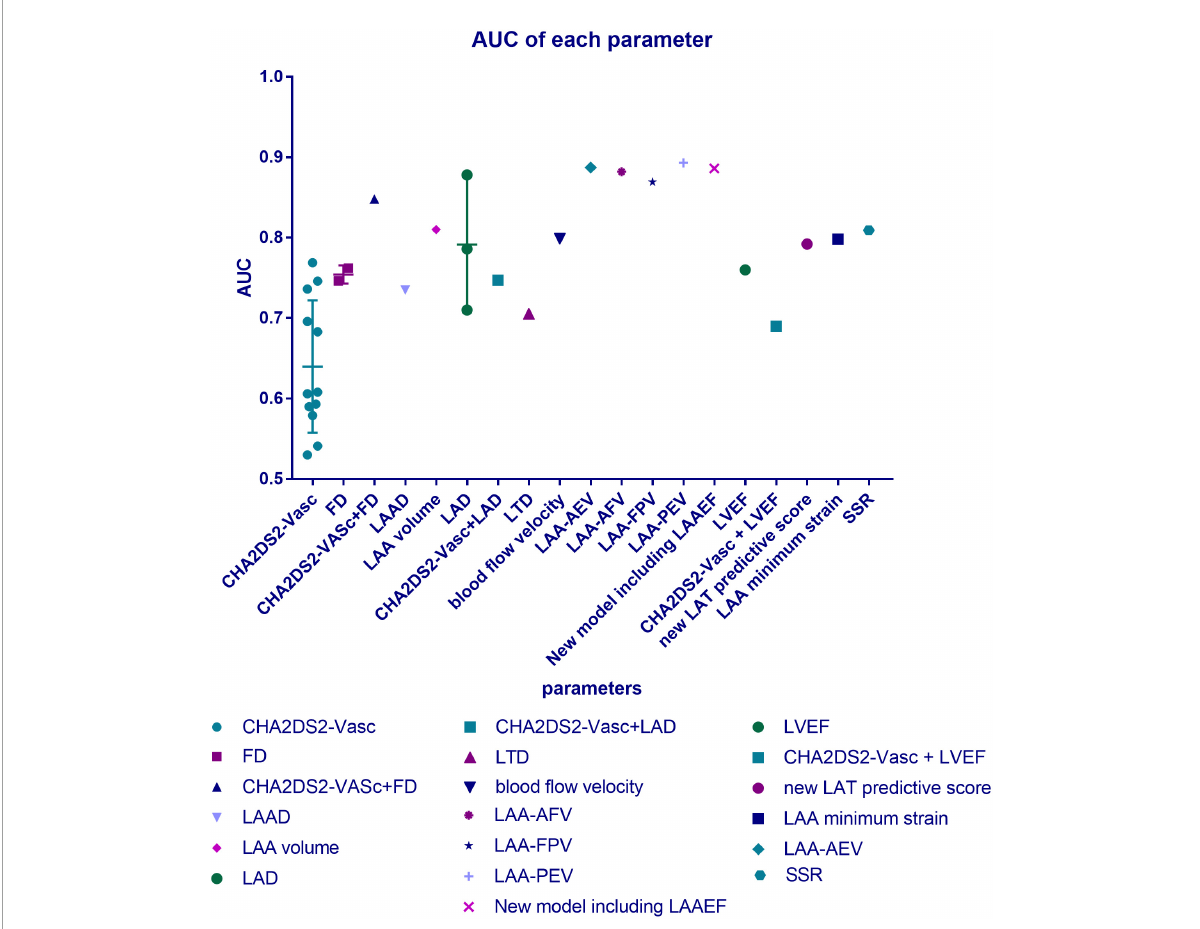
FIGURE1 Distribution of area under the ROC curves (AUCs) of the parameters mentioned. Data were collected from numerous studies reporting the parameters’ predictive value for thrombus risk in patients with atrial fibrillation (AF), and this figure illustrates their distribution. The AUC shows the accuracy of a predictive tool. The closer the AUC is to 1.0, the better the predictor is. AUC = 1.0 means that it is a perfect classifier, (0.85, 0.95) shows a very good effect, while (0.7, 0.85) means the effect is proper, and (0.5, 0.7) gets a moderate effect. When it drops to 0.5, it means that the model has no predictive value, and its result is similar to a random